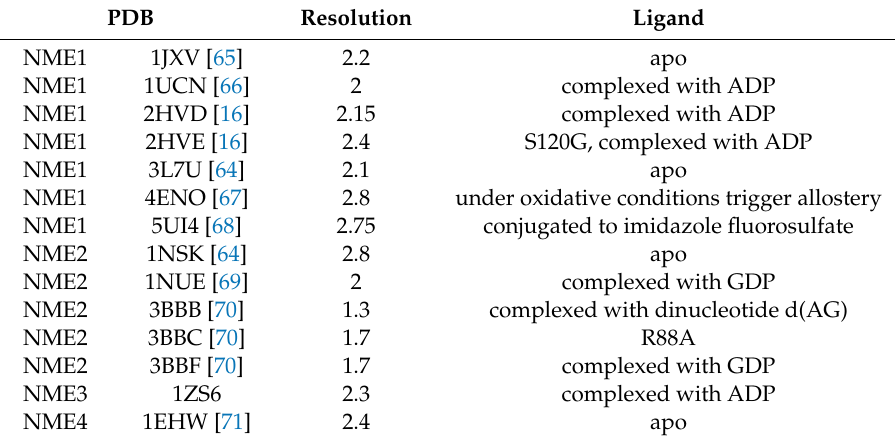
Table 1. Available structures in PDB of all human NME1 to NME4 *.